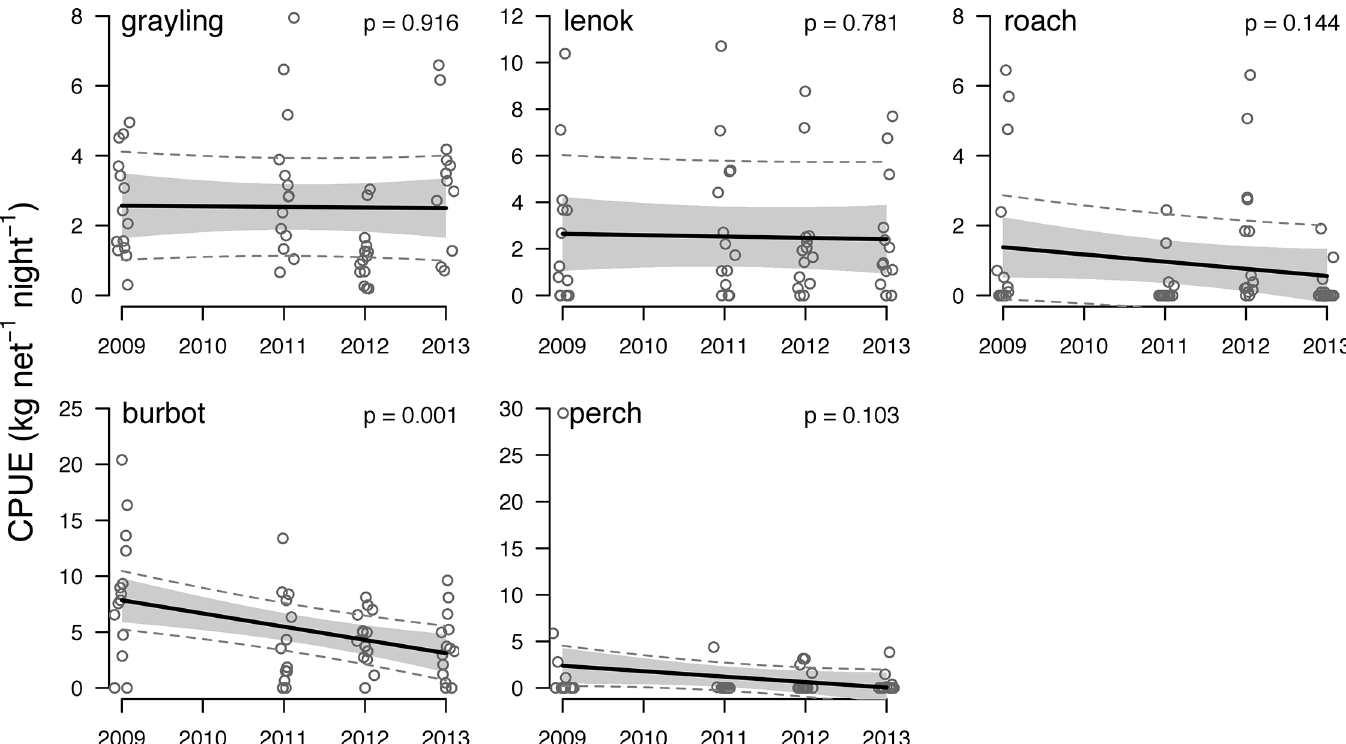
Fig 4. Trends in the abundance of the five most abundant fish species in gillnet catches from 2009 – 2013. Points indicate the CPUE (kg net -1 night -1 ) of each 5-panel sequential mesh gillnet set (2 nets site -1 x 7 sites yr -1 = 14 sets yr -1 ). Dark lines indicate linear mixed effects regressions fit to the catch data, gray shading indicates the confidence interval for each regression, and dashed lines indicate the prediction interval for the data. P-values are indicated in the upper right corner of each panel. Points are jittered around year for display. Note variable y-axis